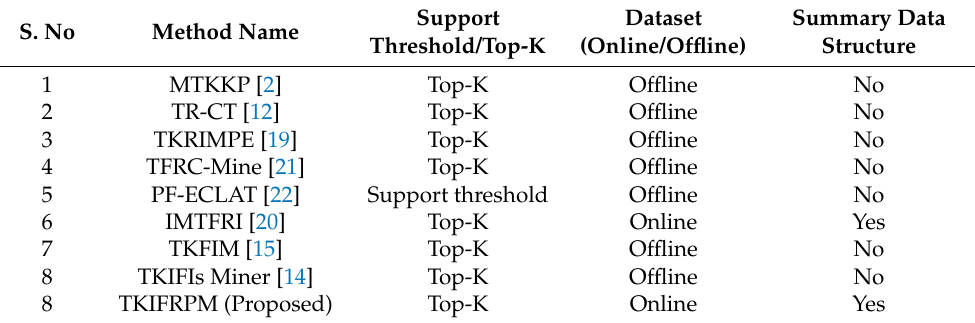
Table 1. Top-level comparison of the topmost frequent regular pattern mining methods. S.